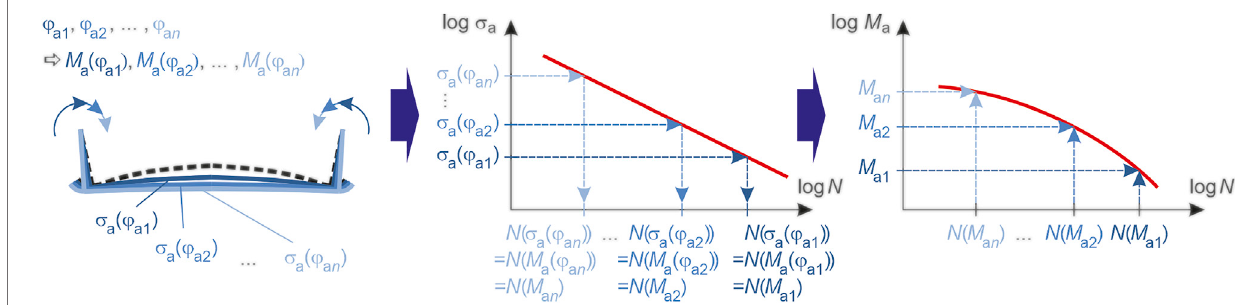
FIGURE 3 | Schematic of the fatigue analysis for determination of the components S - N -curve.